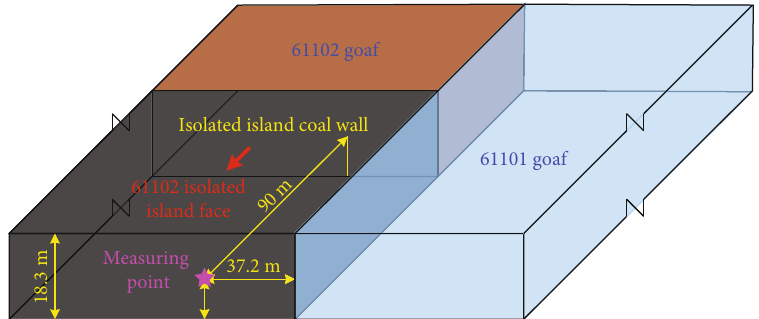
Figure 11: Measuring point location for advance mining stress in the isolated island face.